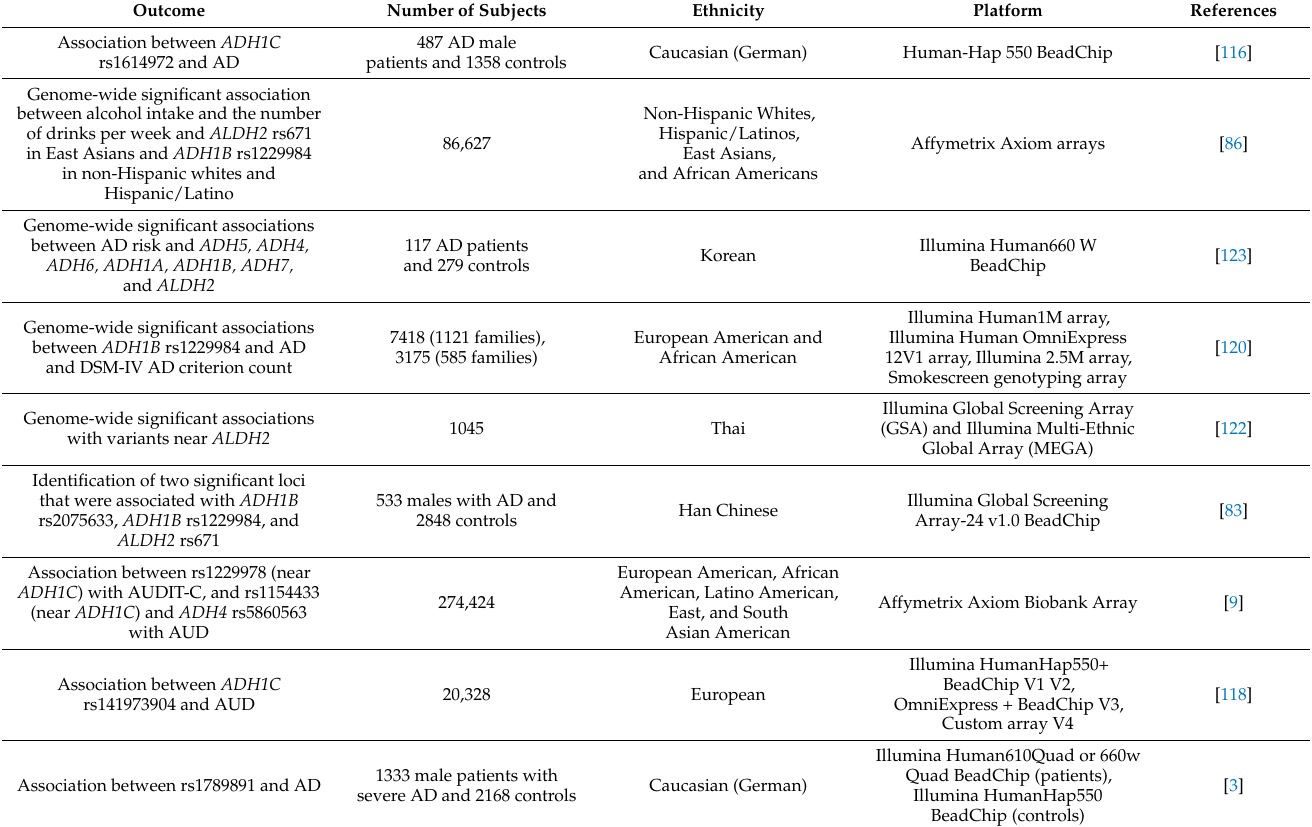
Table 4. GWAS on AUD that observed an association with ethanol metabolism or oxidative stress